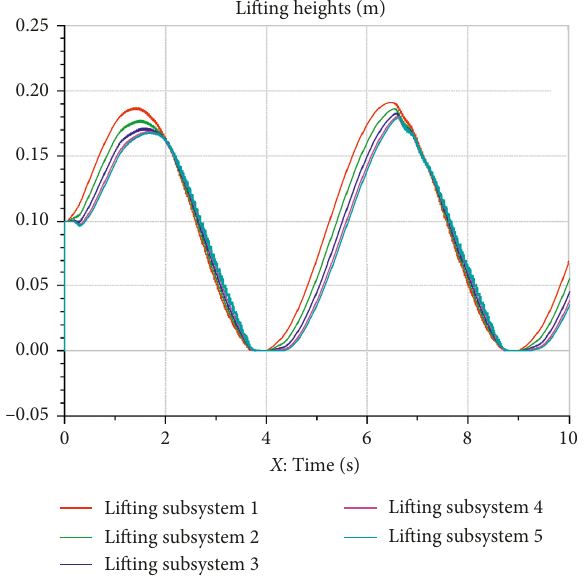
Figure 4: Lifting heights of the Synchronization errors (m)